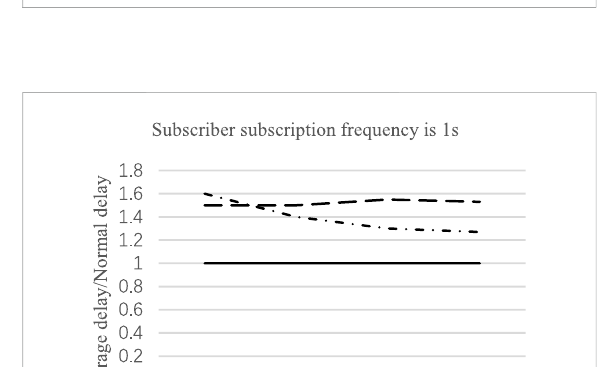
FIGURE 4 Test of distribution frequency over the time period.